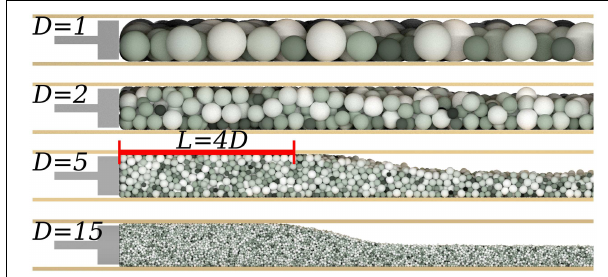
FIGURE 5 | Particle positions for four simulations with varying gap spacing. Top to bottom: D = 1 , 2 , 5 , and 15 . For all cases, φ 0 ≈ 0 . 5 , I = 0 . 01 and the simulation is displayed at the time corresponding to L = 4 D . Particles are colored by size, darker colors representing smaller